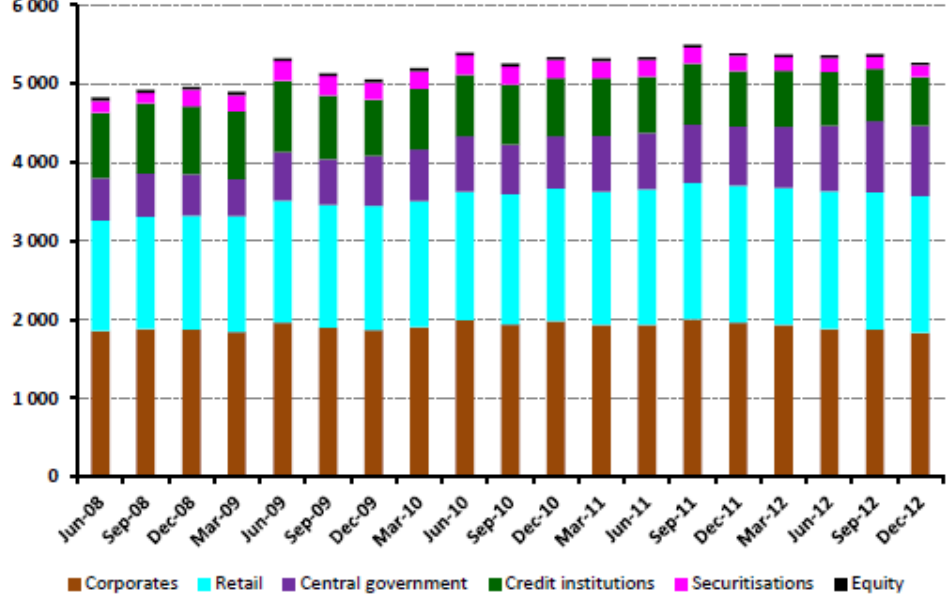
Figure A1. Credit exposures of the French banking sector ( e bn) between 2008 and 2012. Source: Chart 28 in ACP